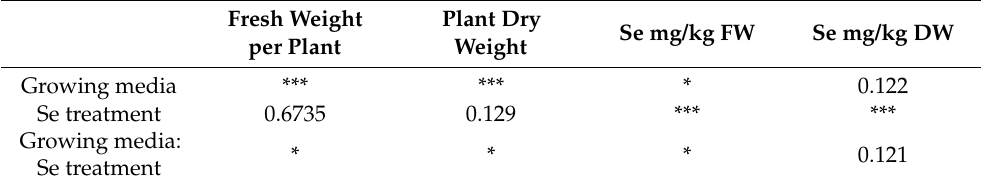
Table 3. Analysis of variance for the fresh and dry weight per plant, and the Se concentrations. * represents significance at p < 0.05, *** represents significance at p < 0.001. In the case of a lack of significant effects, the p -values are given.